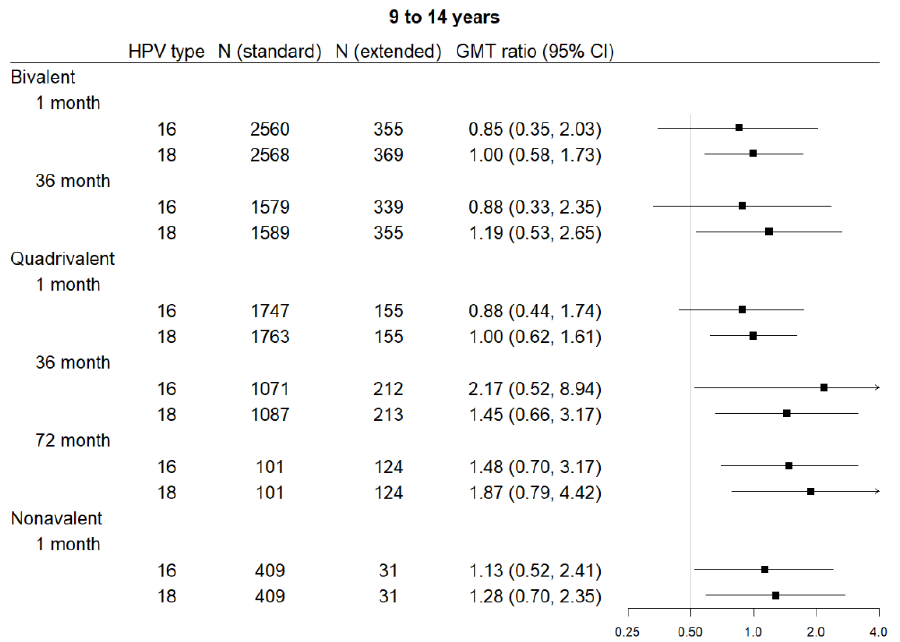
Figure 2. Comparison of pooled geometric mean titer (GMT) for extended interval versus standard schedule (with 95% CI error bars). Vaccines 2020 , 8 , x